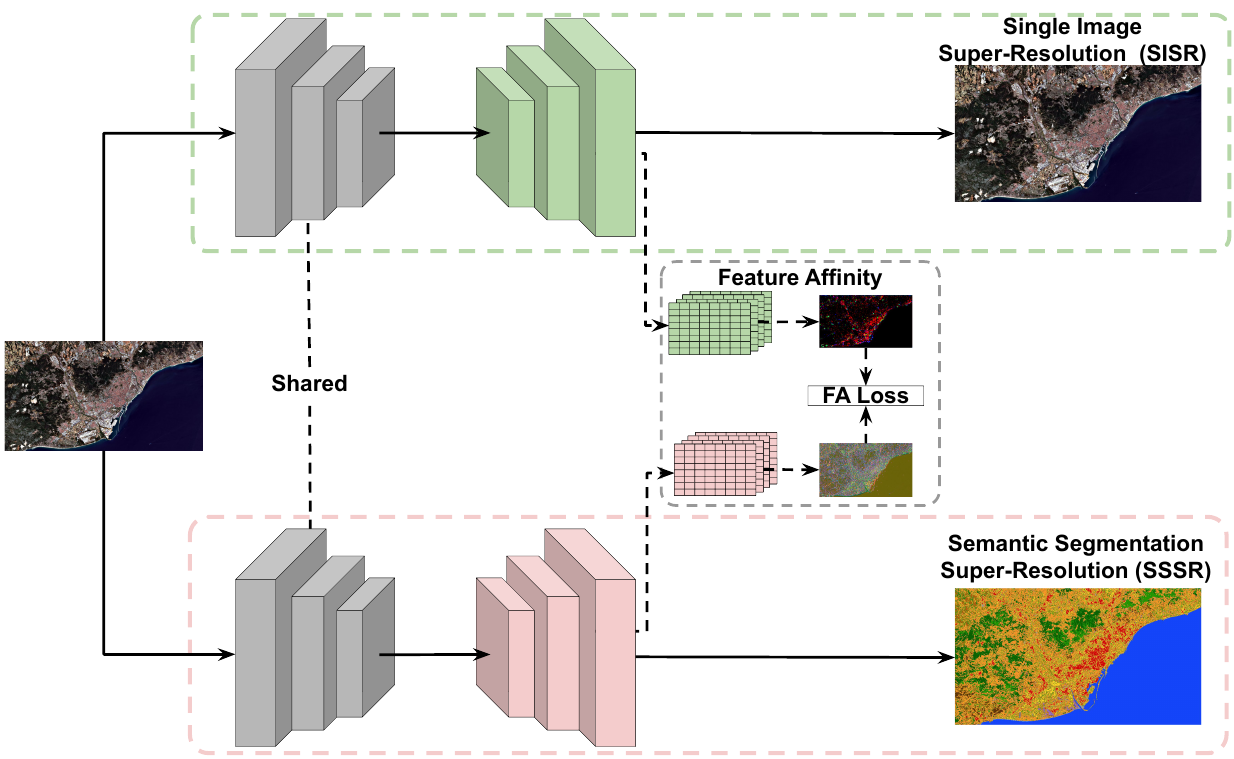
Figure 3. Overview of the Dual Super-Resolution (DSR) architecture composed by three parts: Semantic Segmentation Super-Resolution (SSSR) branch, Single Image Super-Resolution (SISR) branch, and Feature Affinity (FA)